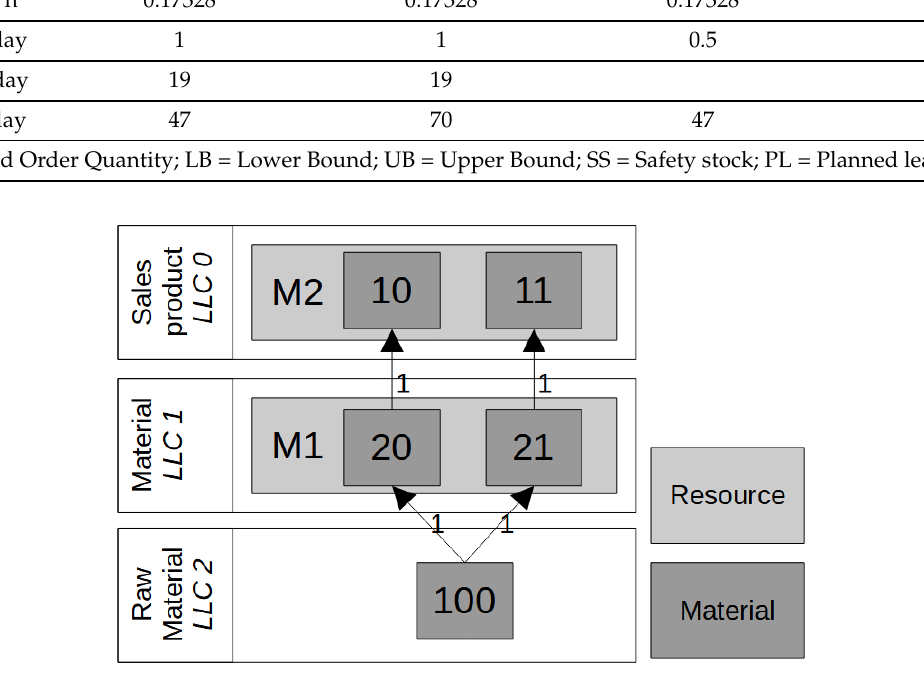
Figure 1. A 3 -level BOM applied during stochastic MRP